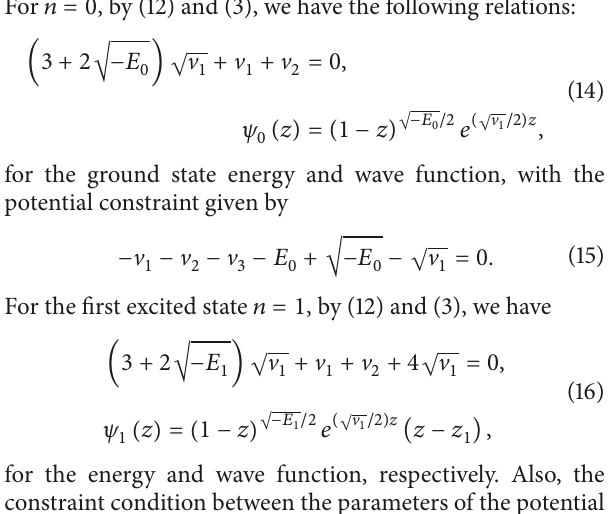
Figure 1: The generalized Manning DW potential with V 1 = 1 , V 2 = −12 , and V = 15.255 3